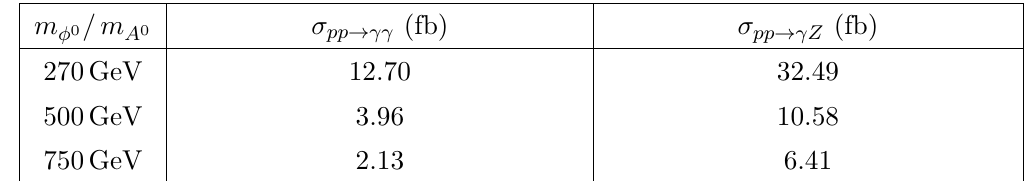
Table 2. Upper limits on the cross-section for spin 0 (cid:6) resonances in the narrow width approxima- p tion from run II ATLAS collaboration at s = 13 TeV and an integrated luminosity of 3.2 fb (cid:0) 1 [1{3].